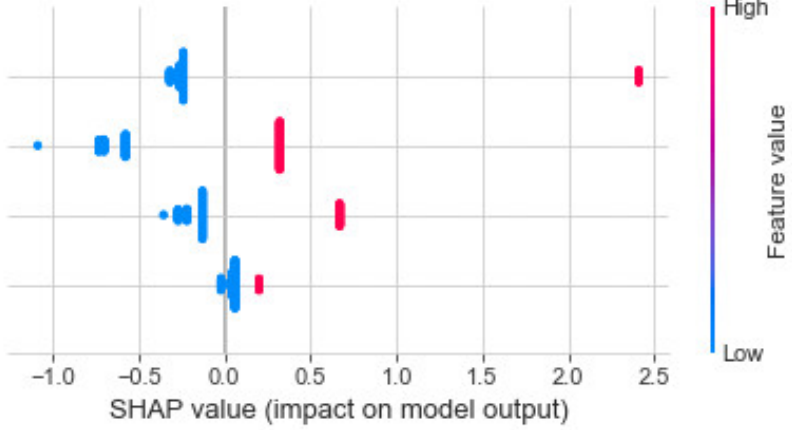
Figure 8. Shapley values for variables related to diabetes.